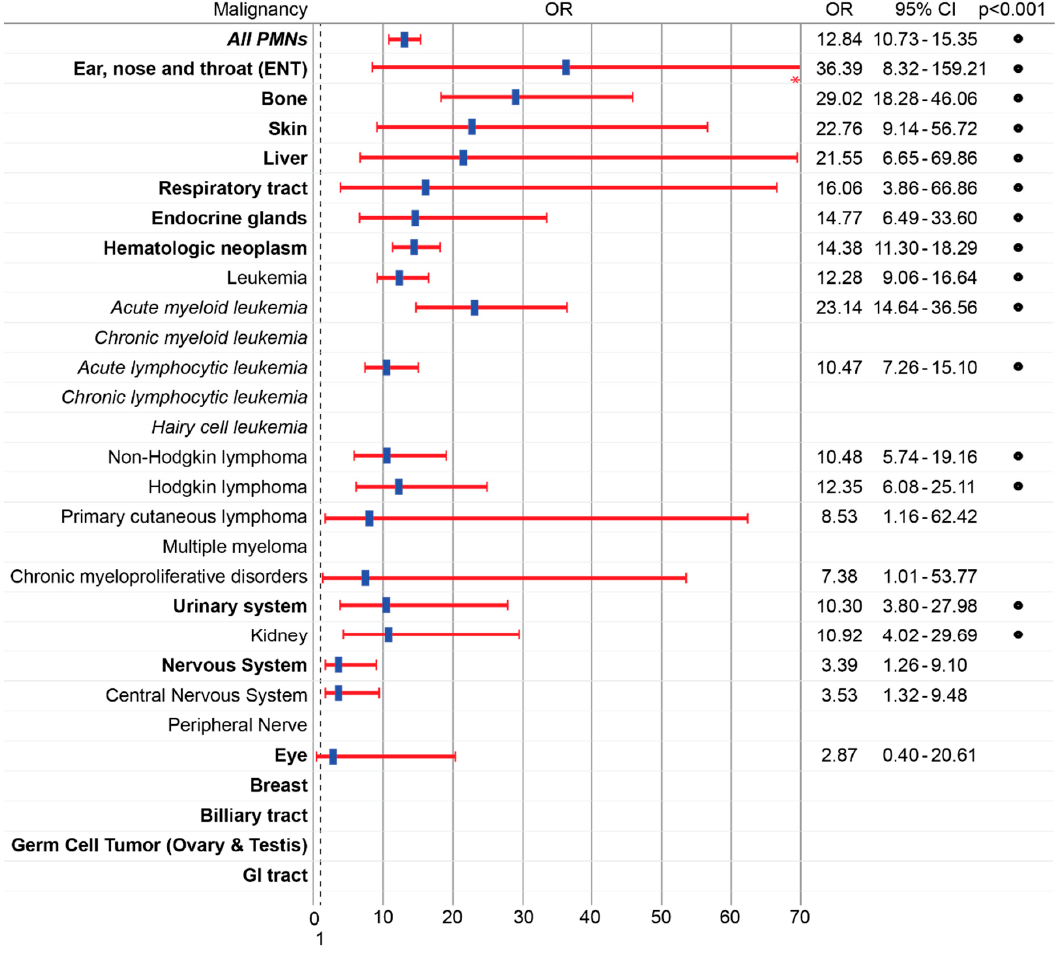
Figure 2. Itching is strongly associated with pediatric malignancies. Odds ratio (OR) with 95% confidence interval (95% CI) of malignancy in patients with compared to without itching in the general pediatric hospital population. Blank rows denote malignancies for which there were no concurrent diagnoses of pruritus. * 95% CI upper limit for ENT (159.2) has been truncated. • = p < 0.001, chi-squared test. Primary malignant neoplasm (PMN).